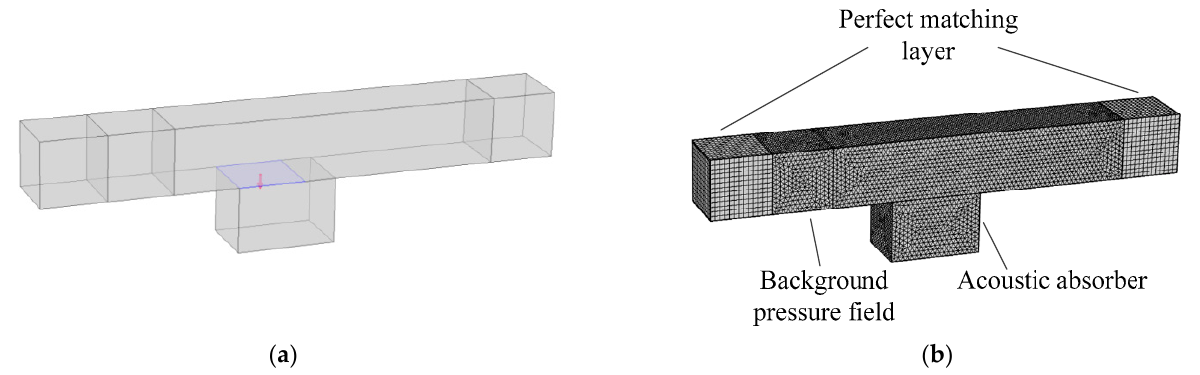
Figure 6. RDBRE system with grazing flow (suitable for the IBNSE method). ( a ) Geometric model. and ( b ) FE model.